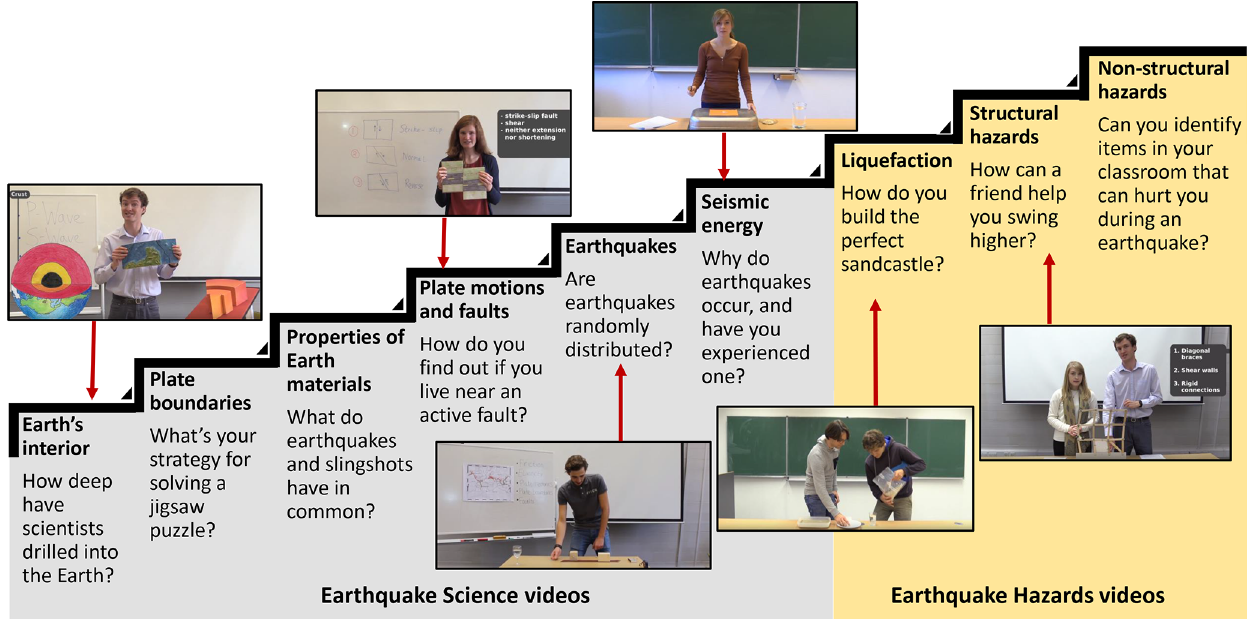
Figure 3. Stepwise earthquake education curriculum (modified from Mohadjer et al.,